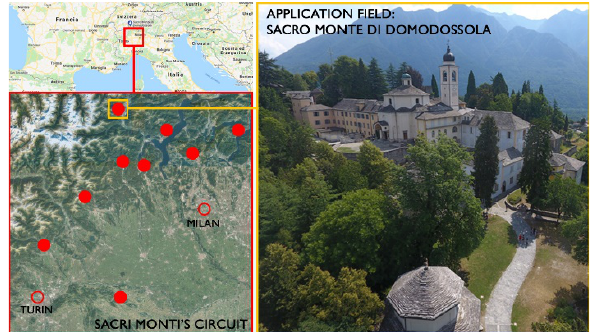
Figure 3: The Sacri Monti Circuit in the North of Italy (on the left), and an aerial view of “Sacro Monte di Domodossola” Sanctuary, which is the application field of the article.